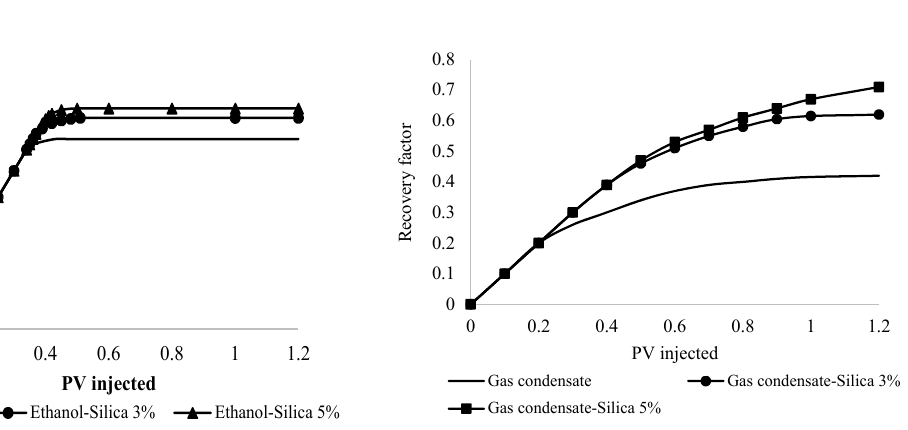
Fig. 9. Oil recovery factor for ethanol base nanofluids